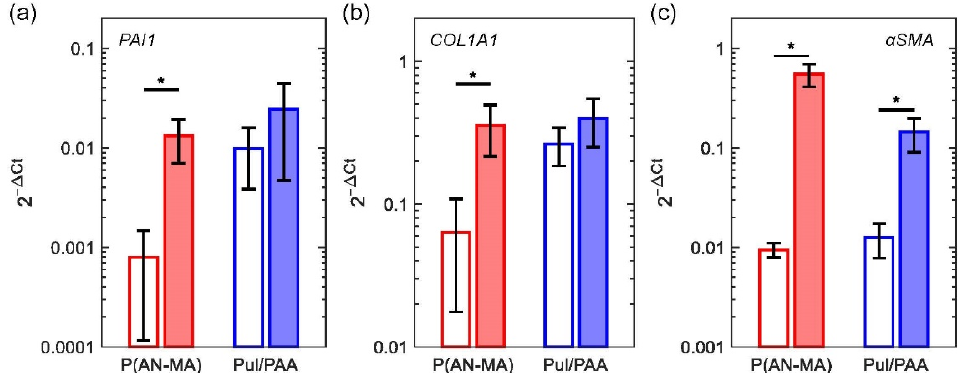
Figure 5. Gene expression of ( a ) PAI1 , ( b ) COL1A1 and ( c ) ACTA2 ( α SMA ) analyzed by qPCR of human skin FBs cultured on electrospun nanofiber mats P(AN-MA) and Pul/PAA after 48 h TGF β (10 ng mL − 1 ) stimulation, white bar = without stimulation and filled bar = TGF β stimulation, n = 3. Significance p < 0.05 (*).